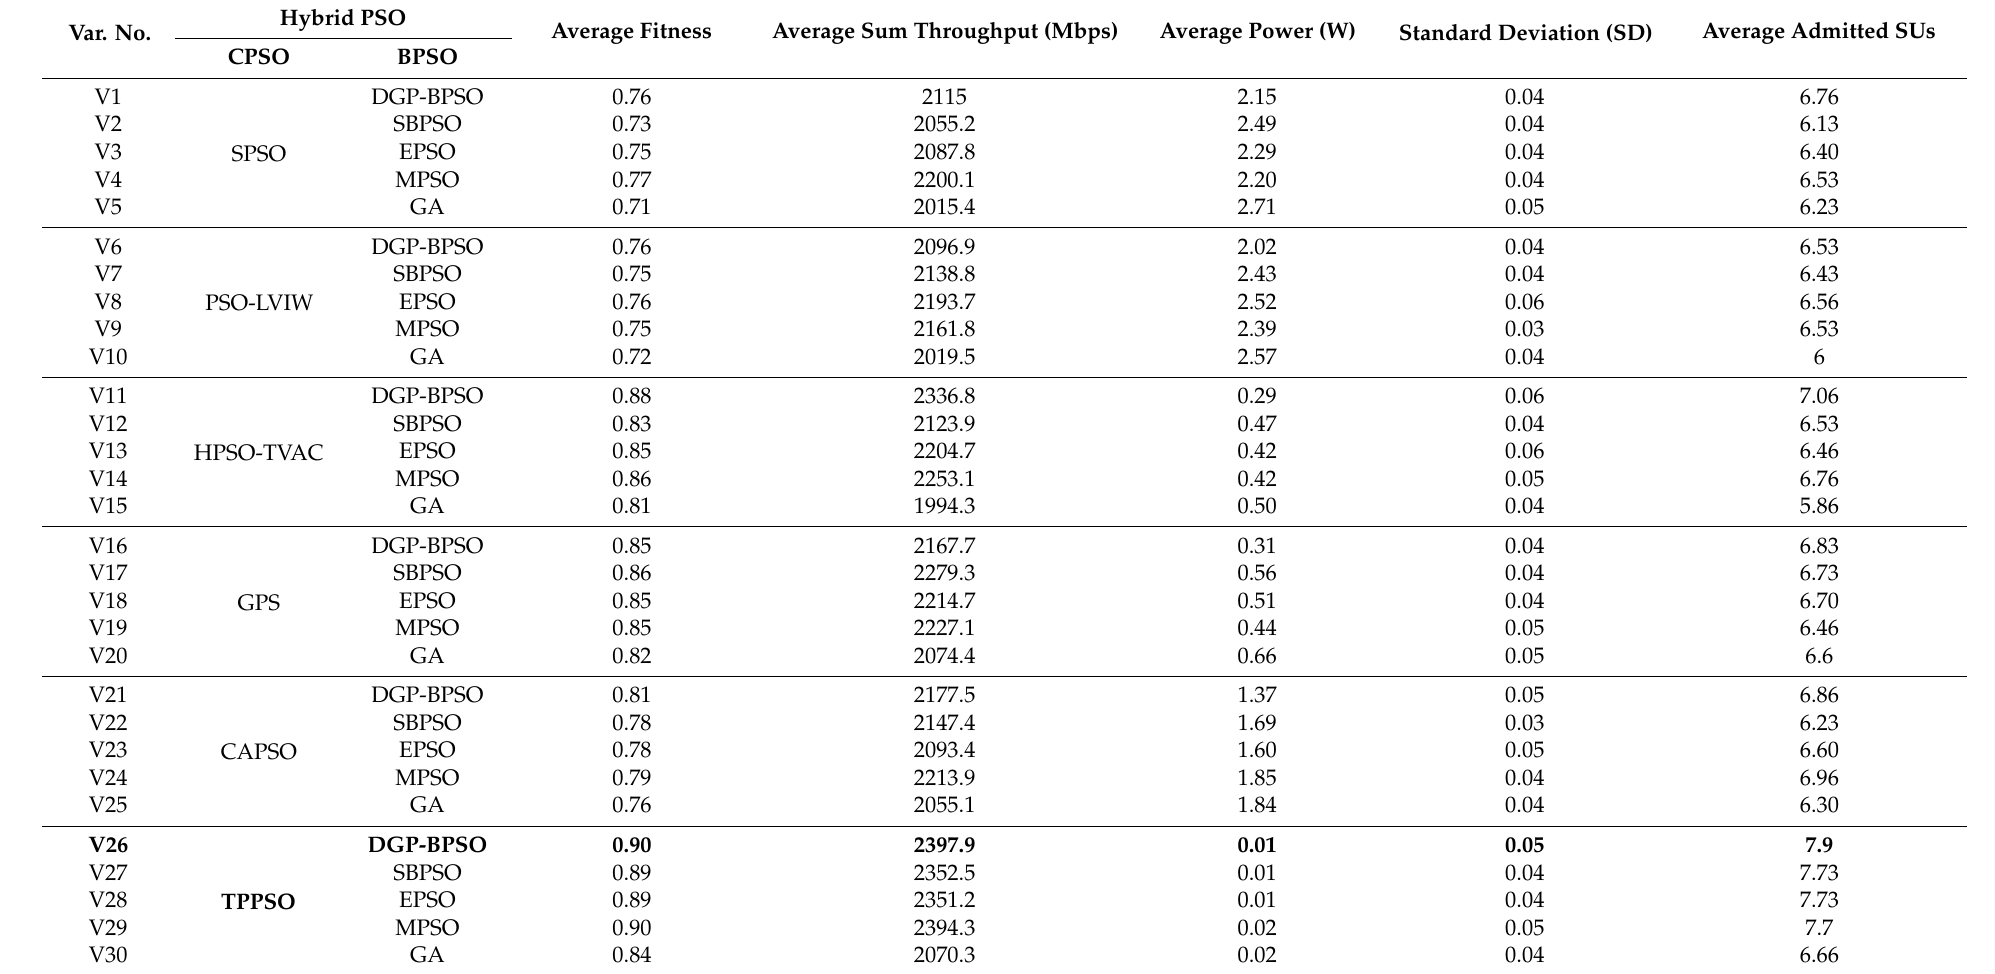
Table 7. Optimization results of the multi-objective function for balanced